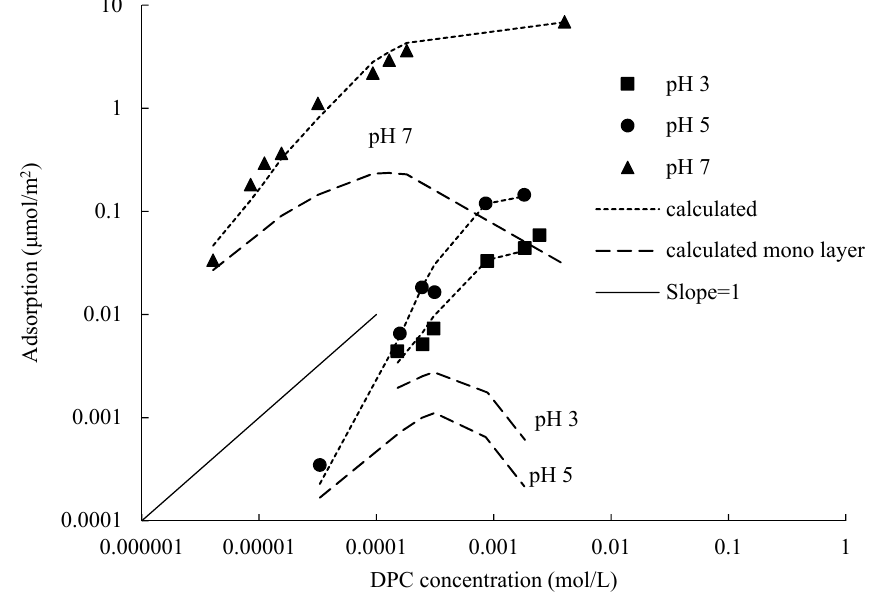
Figure 7. Isotherms modeling of DPC adsorption on silica at 0.1 mol/L electrolyte concentration and different pH.